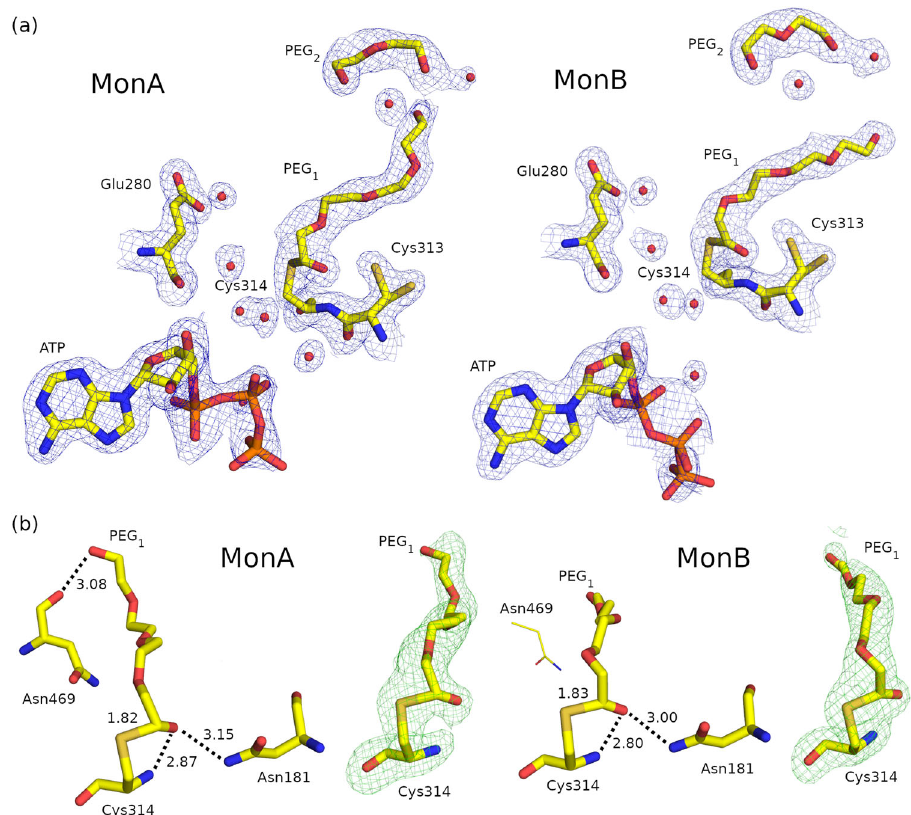
Fig. 6 Cofactor and substrate structures in the ALDH1A3-ATP complex (PDB code 7QK9). a 2Fo − Fc electron density maps contoured at σ = 1 over Cys314, Cys313, Glu280, NAD + , PEG1, PEG2 and water molecules inside the cofactor and substrate-binding pockets. b Polder OMIT maps at σ = 5 over the Cys314 and PEG1, and crystallographic models showing hydrogen bonds between Cys314 and Asn181. The parts of the structure depicted with thin lines in monomer B represent those no longer interacting with the PEG1 molecule, with respect to monomer A.